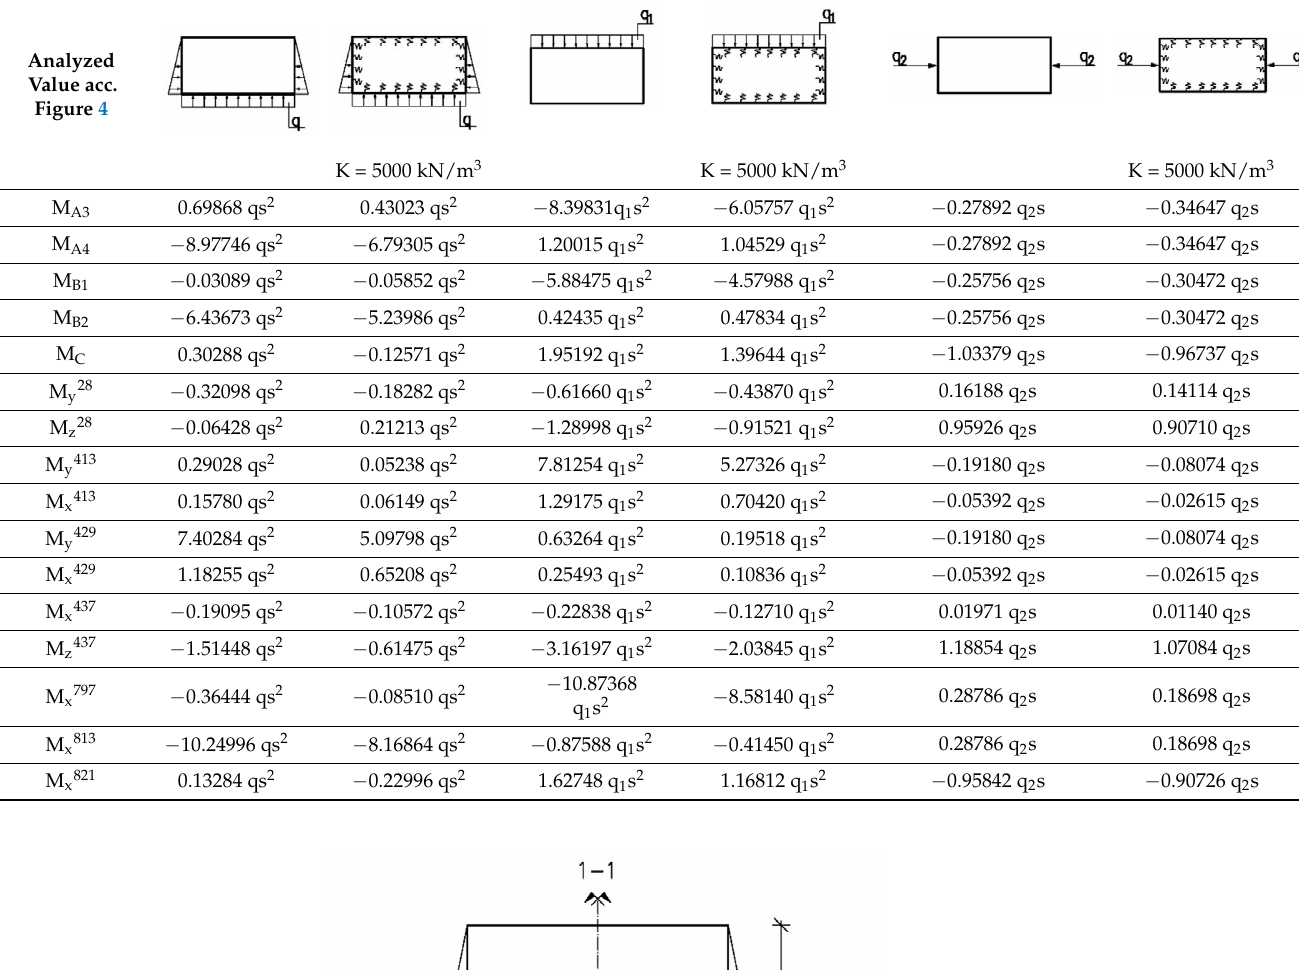
Table 1. Comparison of coefficients proportional to the values of bending moments for the closed tank with an internal partition, with dimensions. l x = 10 m, l y = 2.5 m and l z = 1.25 m calculated with and without taking into account its elastic substrate. The size of mesh division s = l y /12.